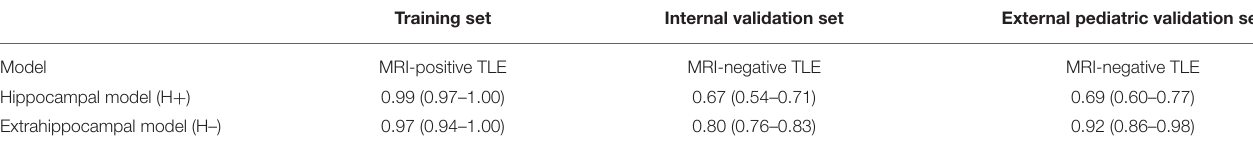
TABLE 3 | Diagnostic performance of the radiomic models in the training set and in patients with MRI-negative temporal lobe